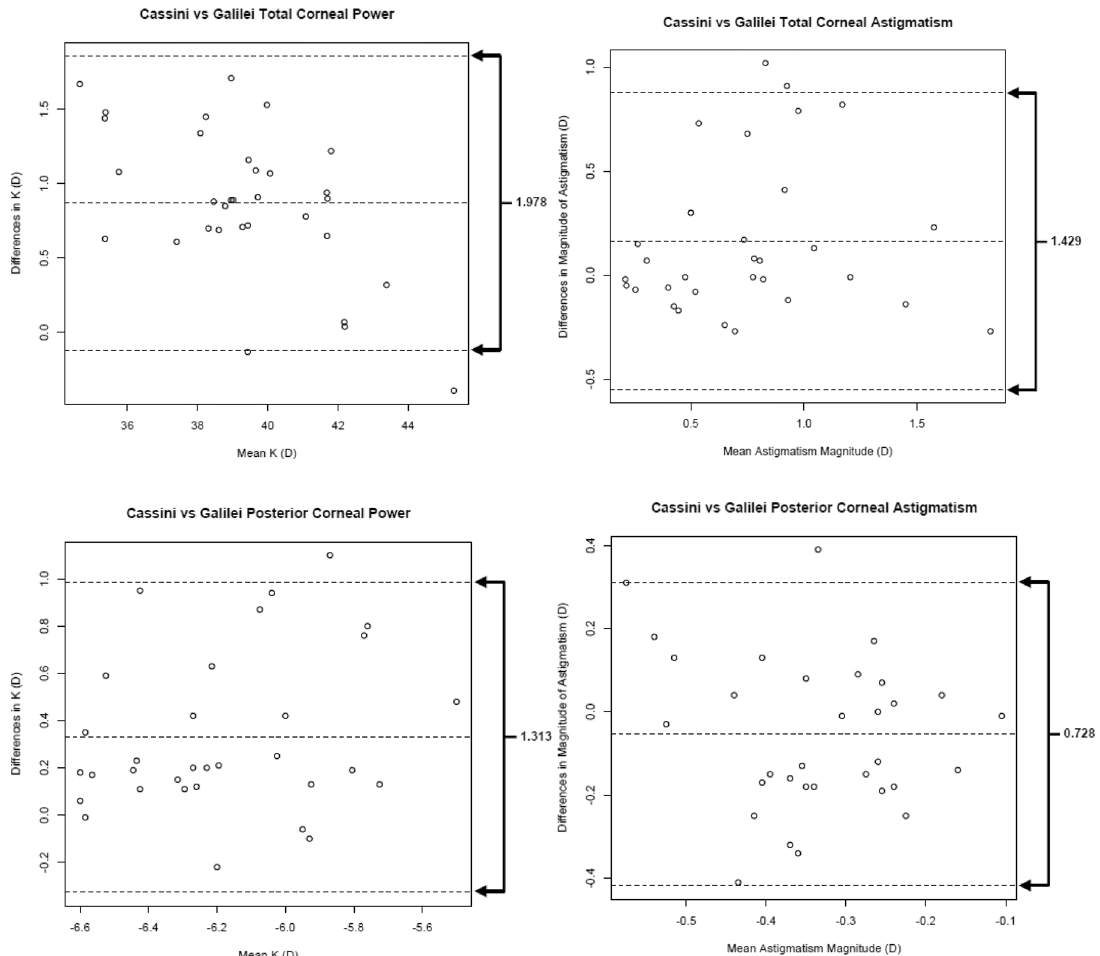
Figure 4. Bland–Altman plots showing differences in corneal power and astigmatism for repeated measurements in post-refractive surgery eyes. The differences were taken between the first and second measurements for each subject. The mean difference is represented by the solid line, and 95% limits of agreement (LoA) are represented by dotted lines. (Top left) total corneal power, (top right) total corneal astigmatism, (bottom left) posterior corneal power, and (bottom right) posterior corneal